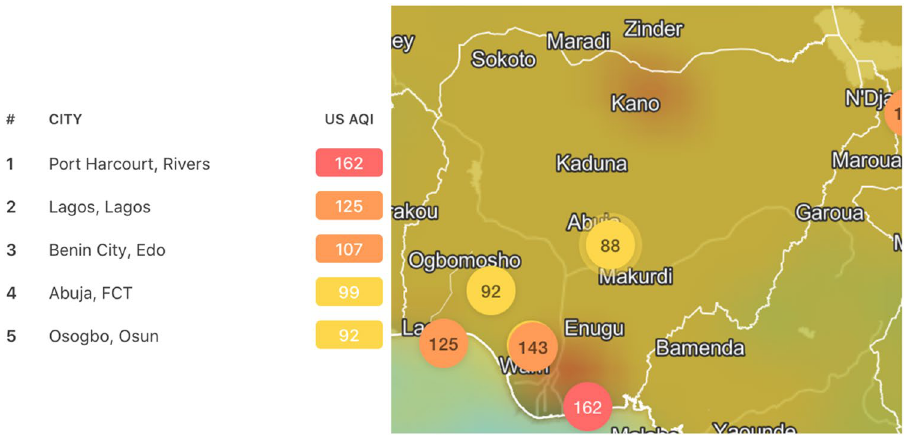
Figure 3. Air quality over selected cities in Nigeria 43